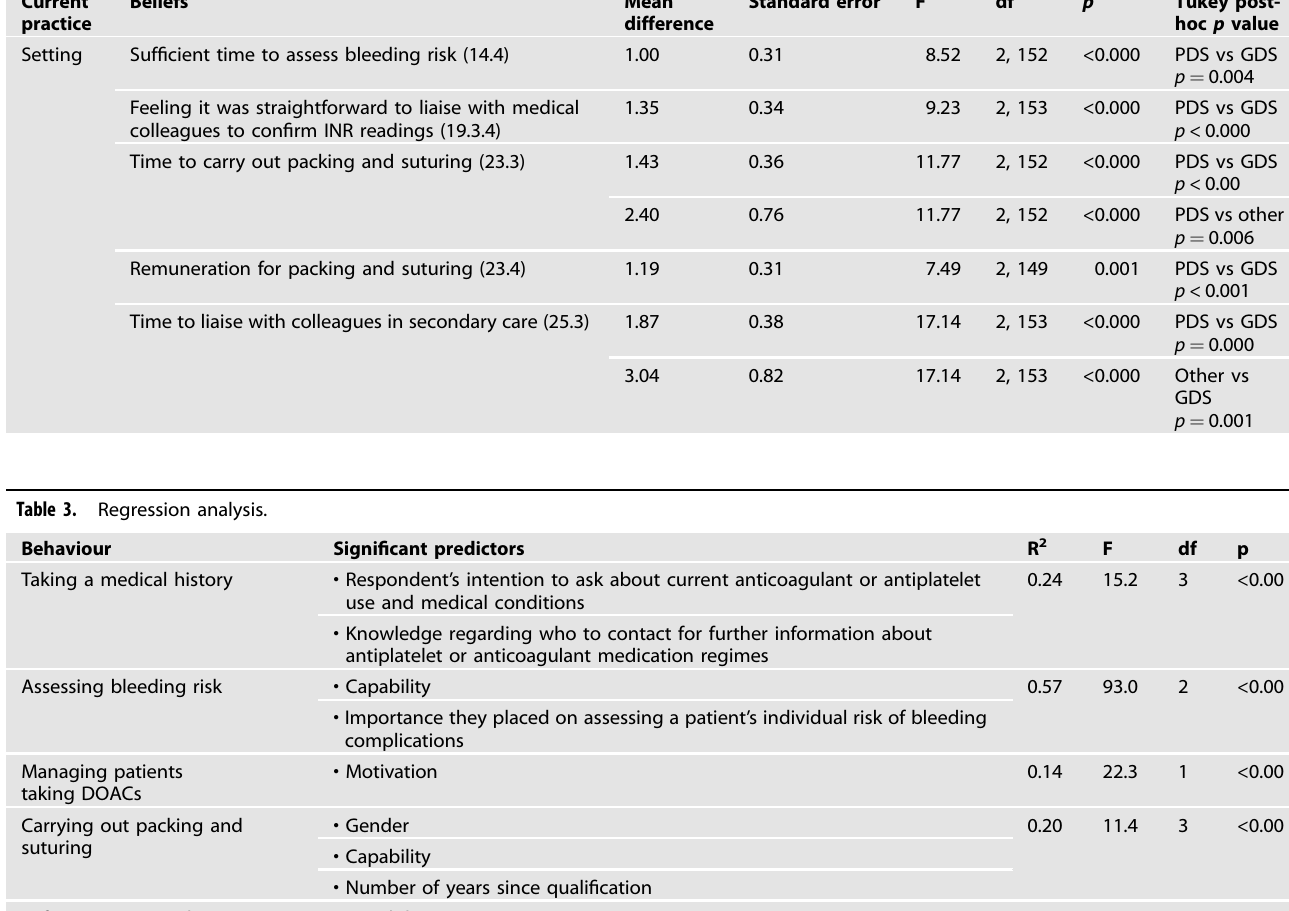
Table 2. ANOVA beliefs and age, setting, years quali fi ed. Current Beliefs Mean practice Setting